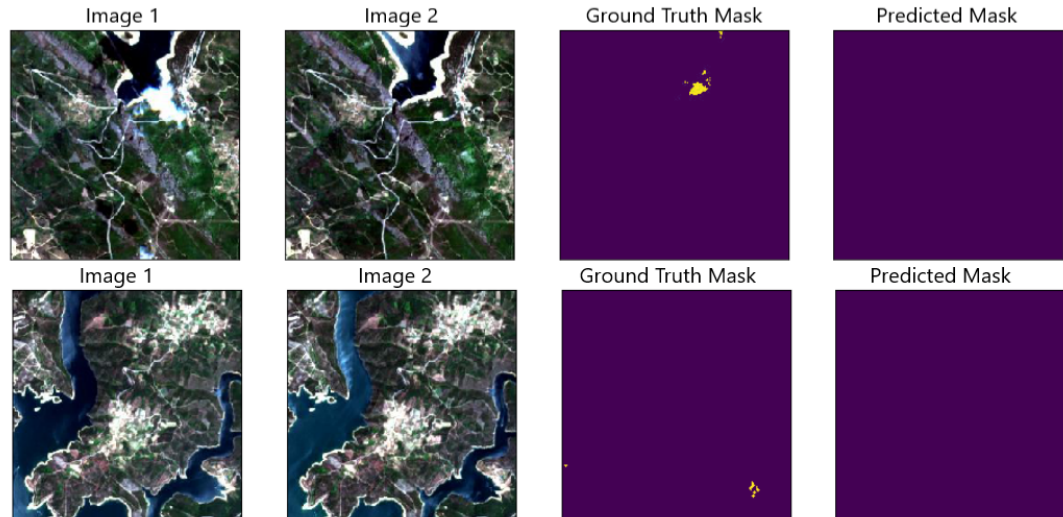
Figure 3. The model correctly predicts negative pixels inside water bodies when the ground truth mask has them marked as positive. For these image pairs, the model does not make the same mistake as the ground truth mask, which erroneously marked parts of the water as burnt